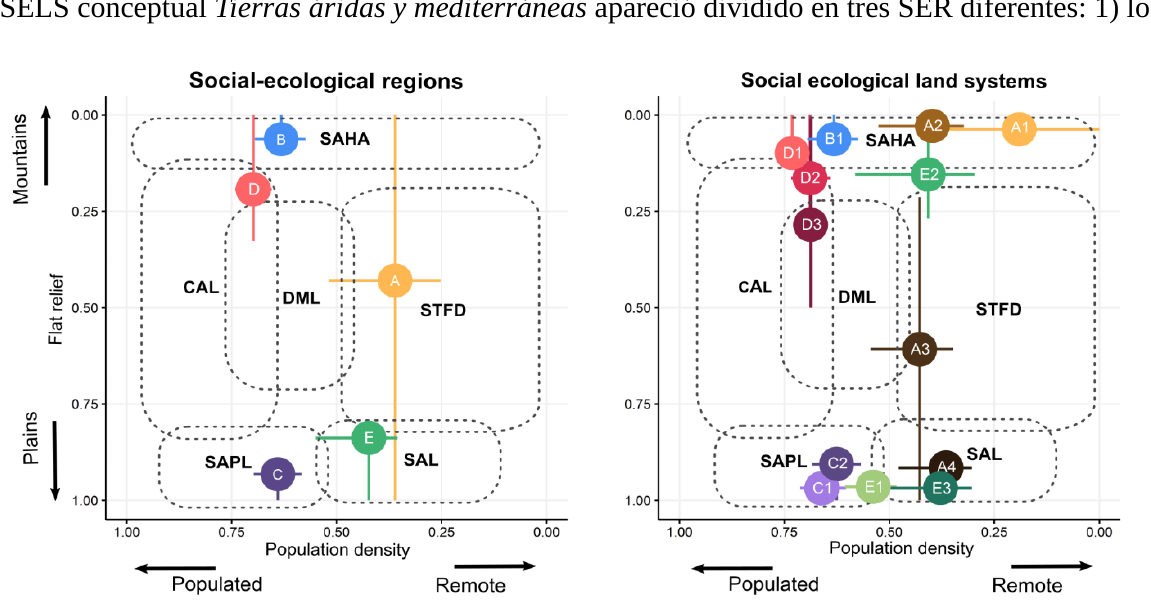
Figura 3. Diagrama de solapamiento entre los SELS conceptuales (Boillat et al. 2017) con los